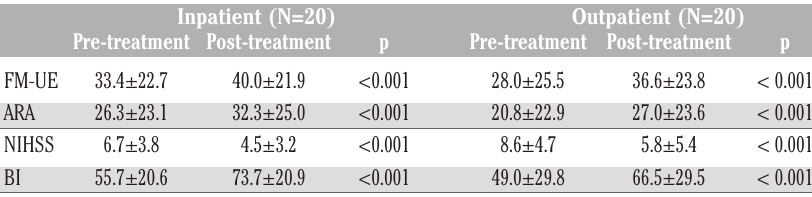
Table 3. Comparison of pre- and post-treatment outcome scores